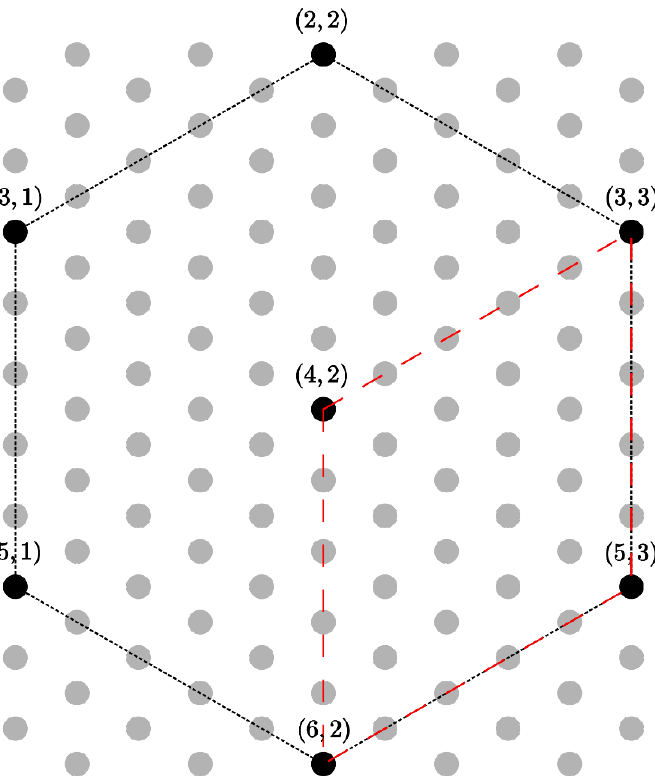
Figure 2. Representation of the field plots positioned in the discrete space. One systematic sample using a sampling interval of 𝑎 = 5 is indicated by the black circles and unsampled plots are indicated by the gray circles. The standardized discrete positions vectors, 𝒕 ℎ𝑖 , are indicated in the parentheticals, and the neighborhood structures (Section 2.3) for 𝐷 𝑀𝐴𝑇,ℎ𝑒𝑥 ((4,2)) and 𝐷 𝑀𝐴𝑇,𝑝𝑎𝑟 ((4,2)) are given by the dotted black line and dashed red line, respectively. Note that 𝐷 𝑀𝐴𝑇,ℎ𝑒𝑥 includes the center point in the set as well as the outer points.